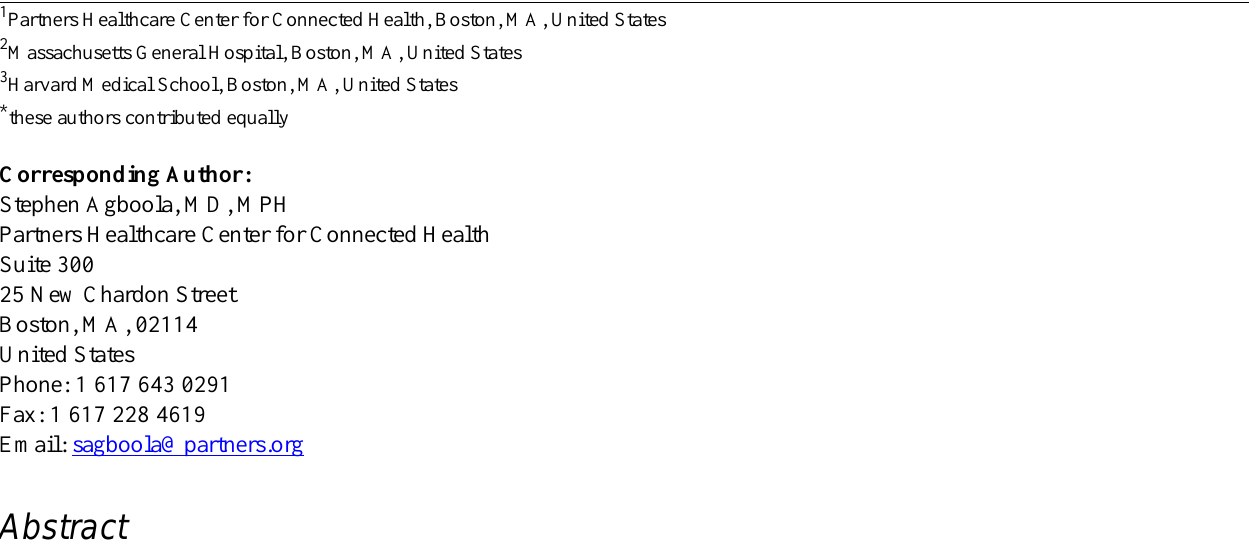
telehealth; eHealth; evaluation; evaluation framework; diabetes mellitus;